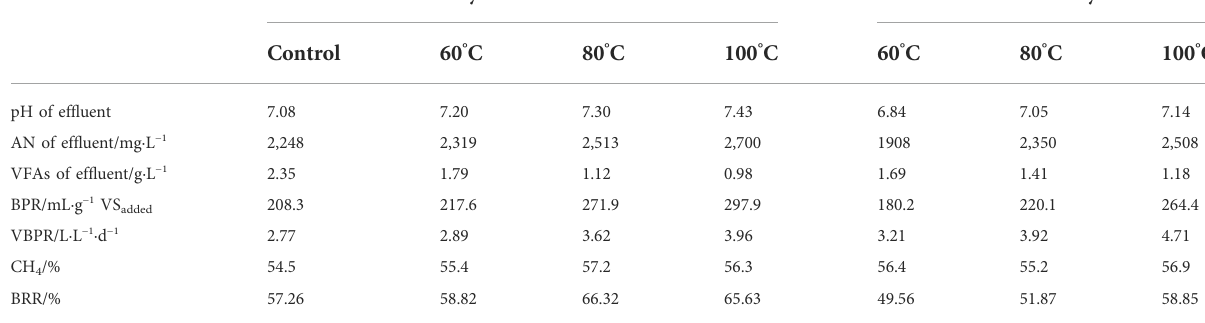
TABLE 3 Performance of biogas production in semi-continuous AD process.